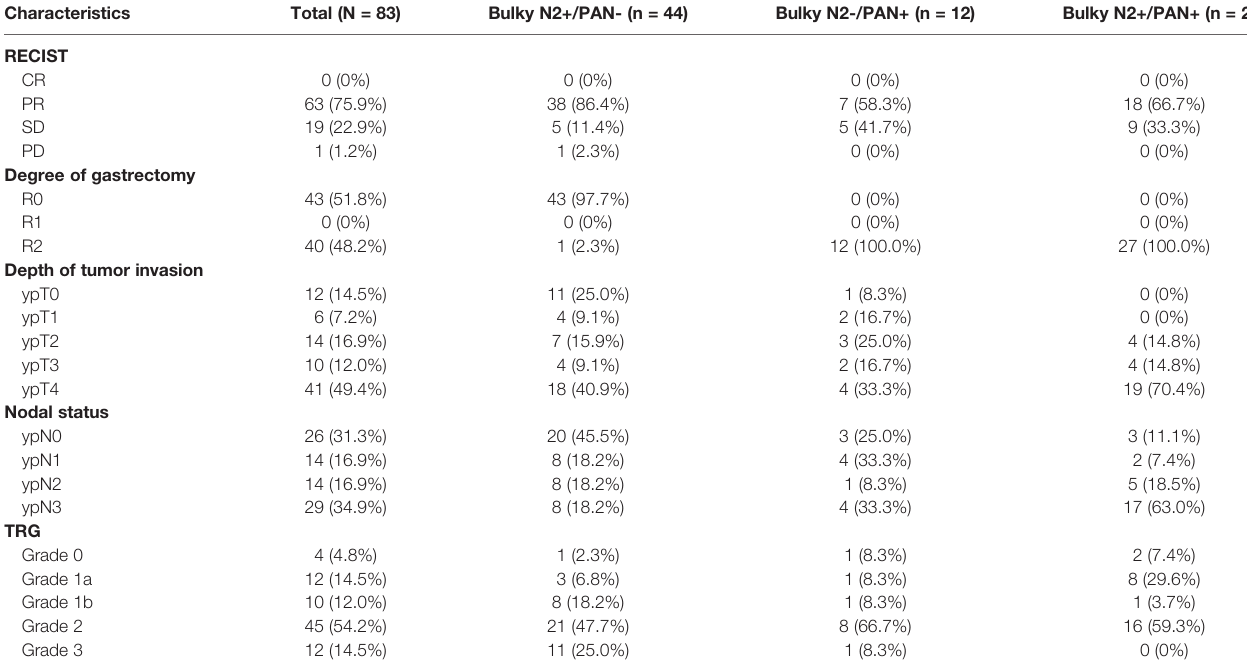
TABLE 2 | Evaluation of preoperative